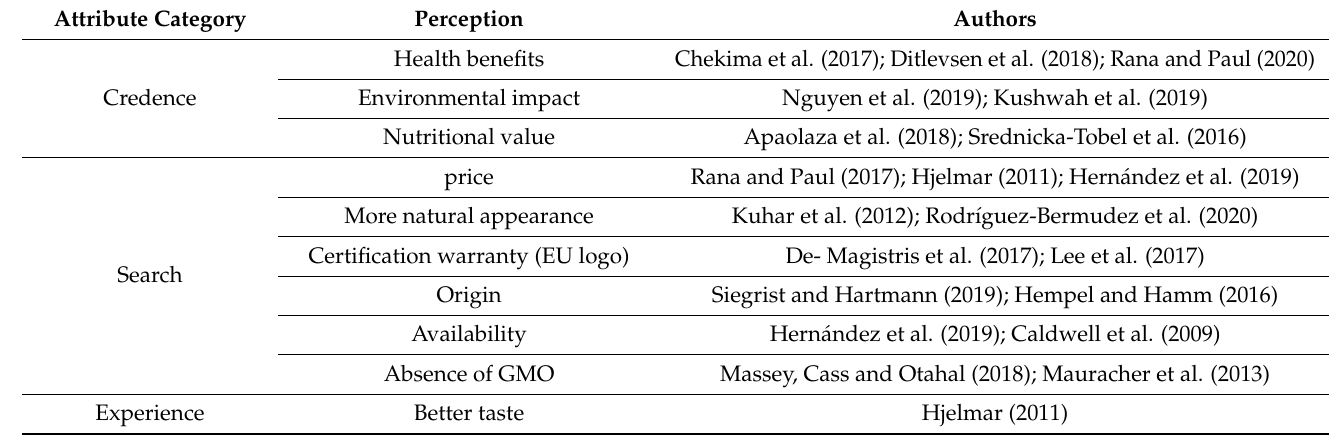
Table A1. Credence, Search and Experience Attributes Used in the Questionnaire.